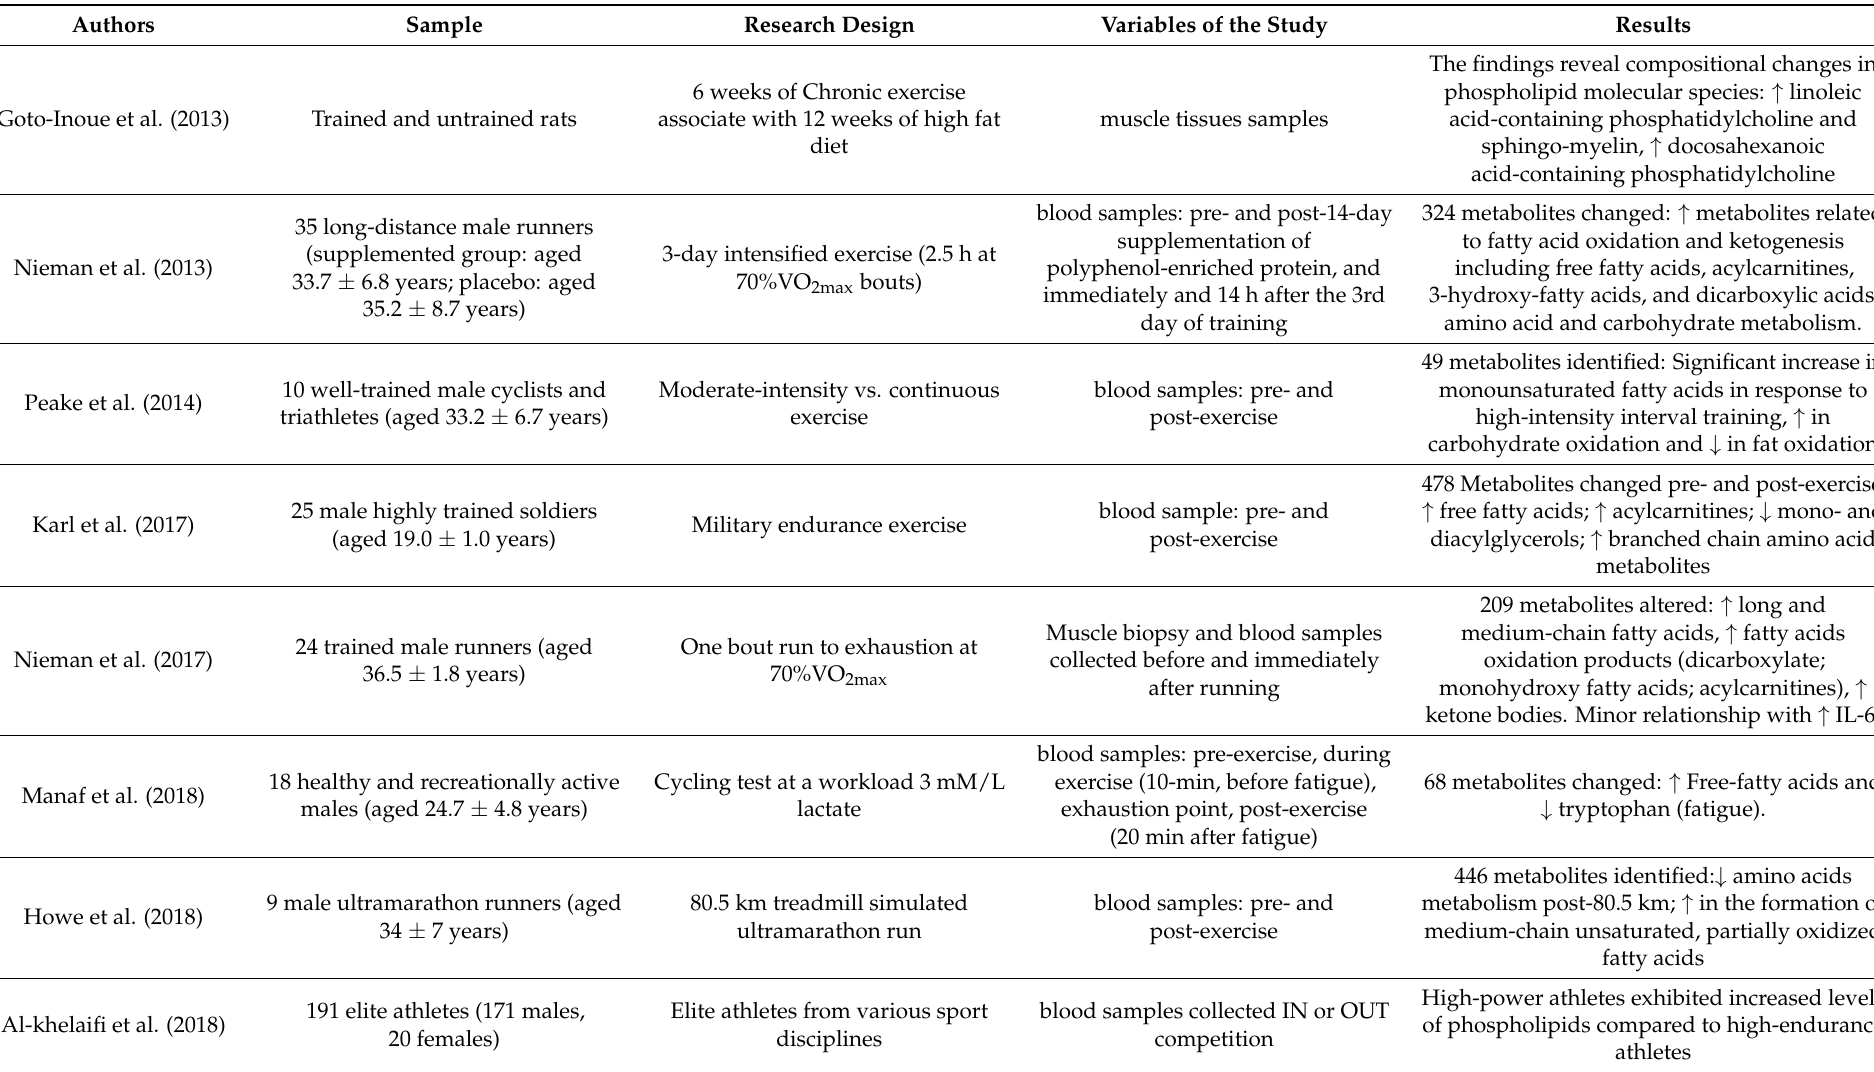
Table 1. Summary characteristics of reviewed